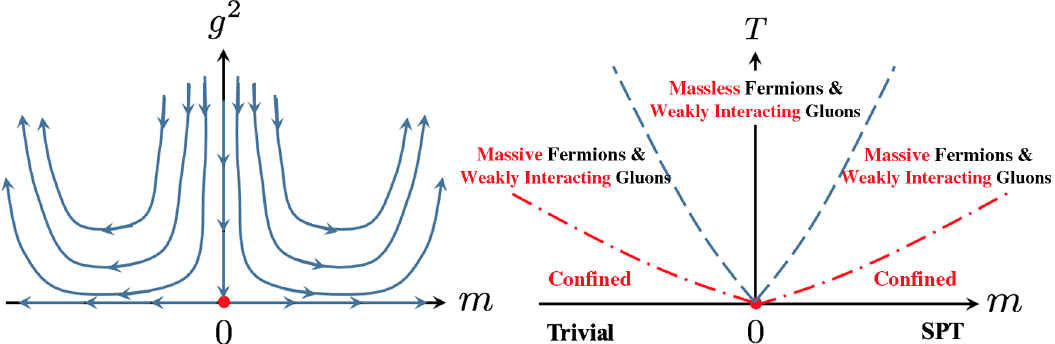
FIG. 3. On the left is a schematic demonstration of renormalization flow in the g 2 − m plane for large N coupling g 2 is a dangerous irrelevant operator for the m ¼ 0 critical point. On the right is the finite-temperature phase diagram for the deconfined quantum phase transition. It features two interesting crossover scales. At temperature T ≫ m (or length scale l ≪ ξ ∼ 1 =m ), the physics is controlled by the critical point, and the system has deconfined massless fermions with weakly interacting gluons. For temperature m y ≪ T ≪ m (or length scale ξ ≪ l ≪ ξ y ) with y > 1 a universal exponent, the system has deconfined but massive fermions and weakly interacting gluons. For temperature lower than about m y (or l ≫ ξ y ), the gauge theory flows to strong coupling and the system is in a confined